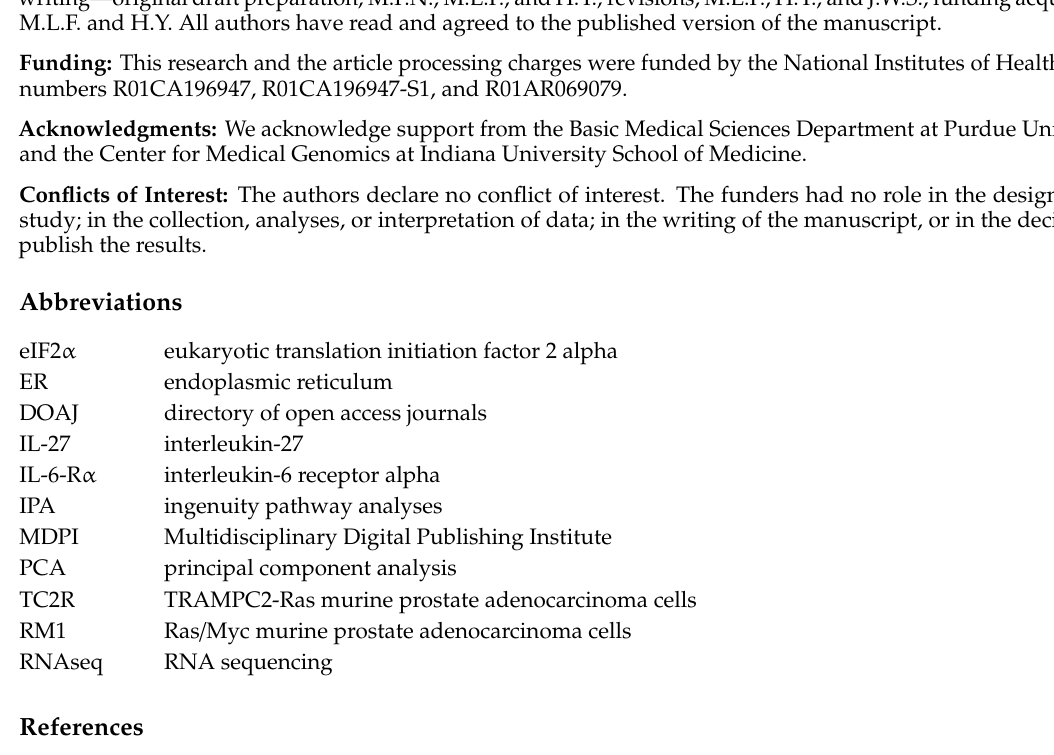
Figueiredo Neto, M.; Figueiredo, M.L. Combination of Interleukin-27 and MicroRNA for